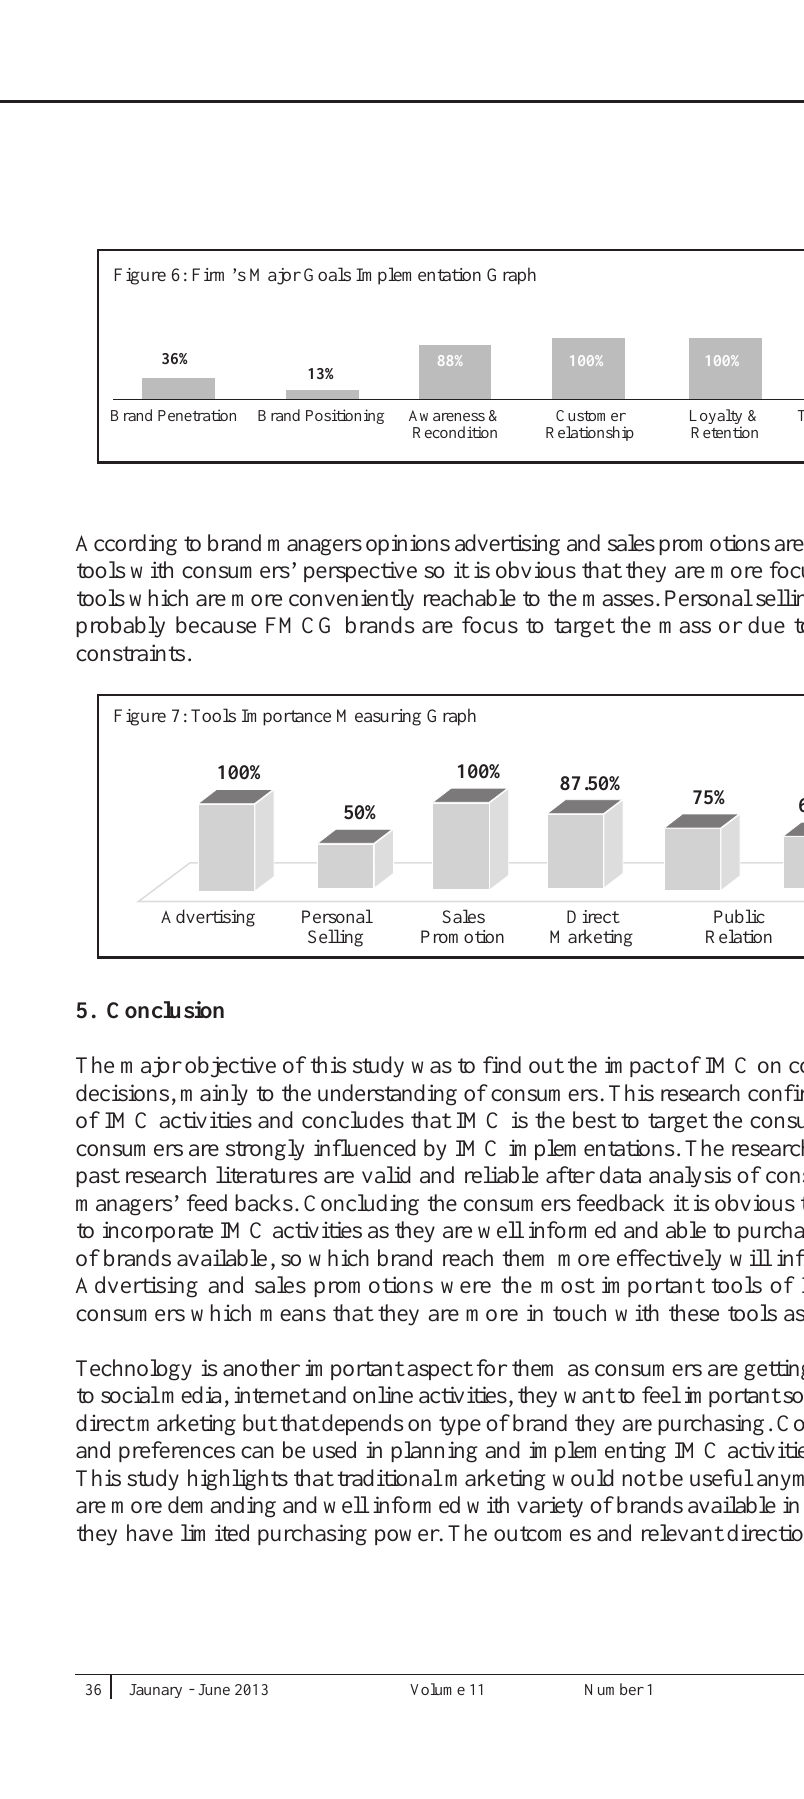
Brand Penetration Brand Positioning Awareness &